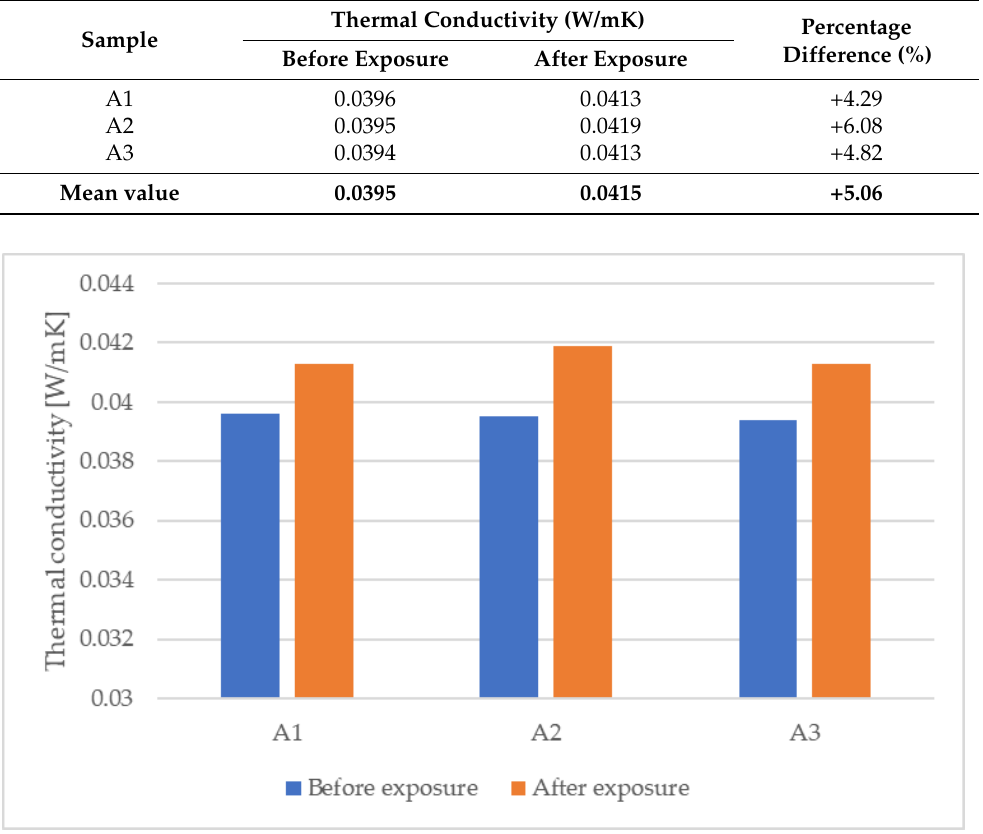
6 of 9 Figure 4. Graphic representation of weight variation. The decrease in thermal performance of expanded polystyrene samples is also shown